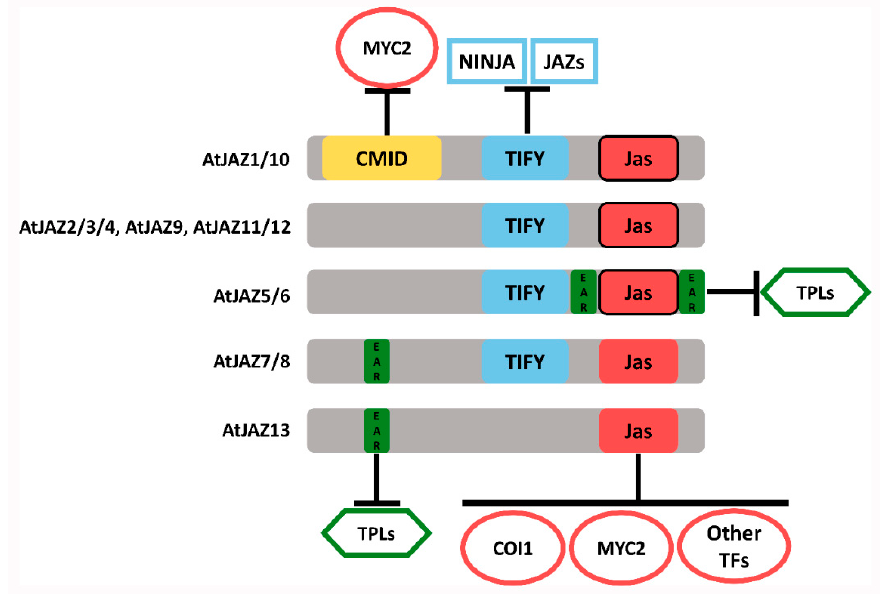
Figure 1. Schematic representation of Arabidopsis thaliana JAZ proteins showing the main motifs and domains through which they interact with other proteins (interactions indicated by T-bars and proteins by circles, rectangles and hexagons). Frame boxes of Jas domains indicate the conservation of functional degrons. CMID, Cryptic MYC2-interacting domain; COI1, CORONATINE INSENSITIVE1; EAR, ethylene-responsive element binding factor-associated amphiphilic repression; JAZ, jasmonate ZIM-domain; NINJA, Novel Interactor of JAZ; TFs, transcription factors; TPL, TOPLESS. This figure is based on References